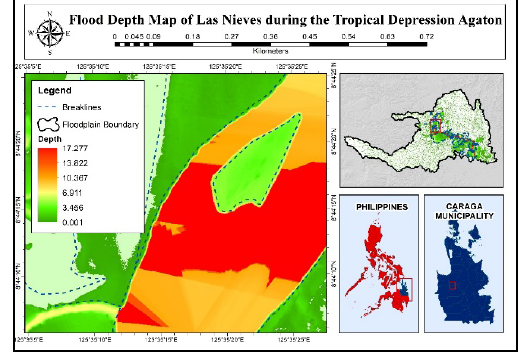
Figure 14 . Flood Depth Map of Las Nieves during the Tropical Depression Agaton using the Existing 2014 LiDAR DTM.